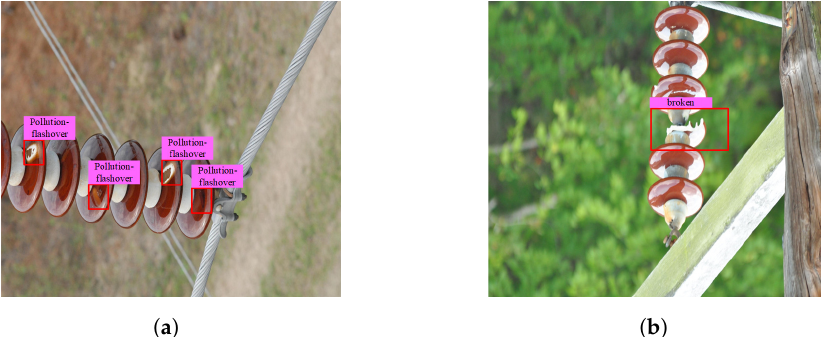
Figure 1. Two different types of defects: ( a ) pollution flashover; ( b ) damage.